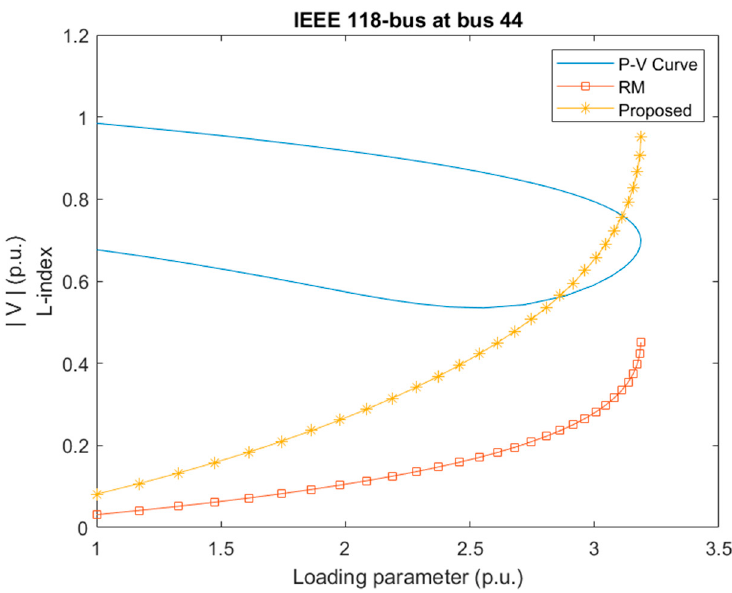
Figure 8. Comparison with L-index between the proposed method and the RM at load bus 44 for IEEE 118-bus network.